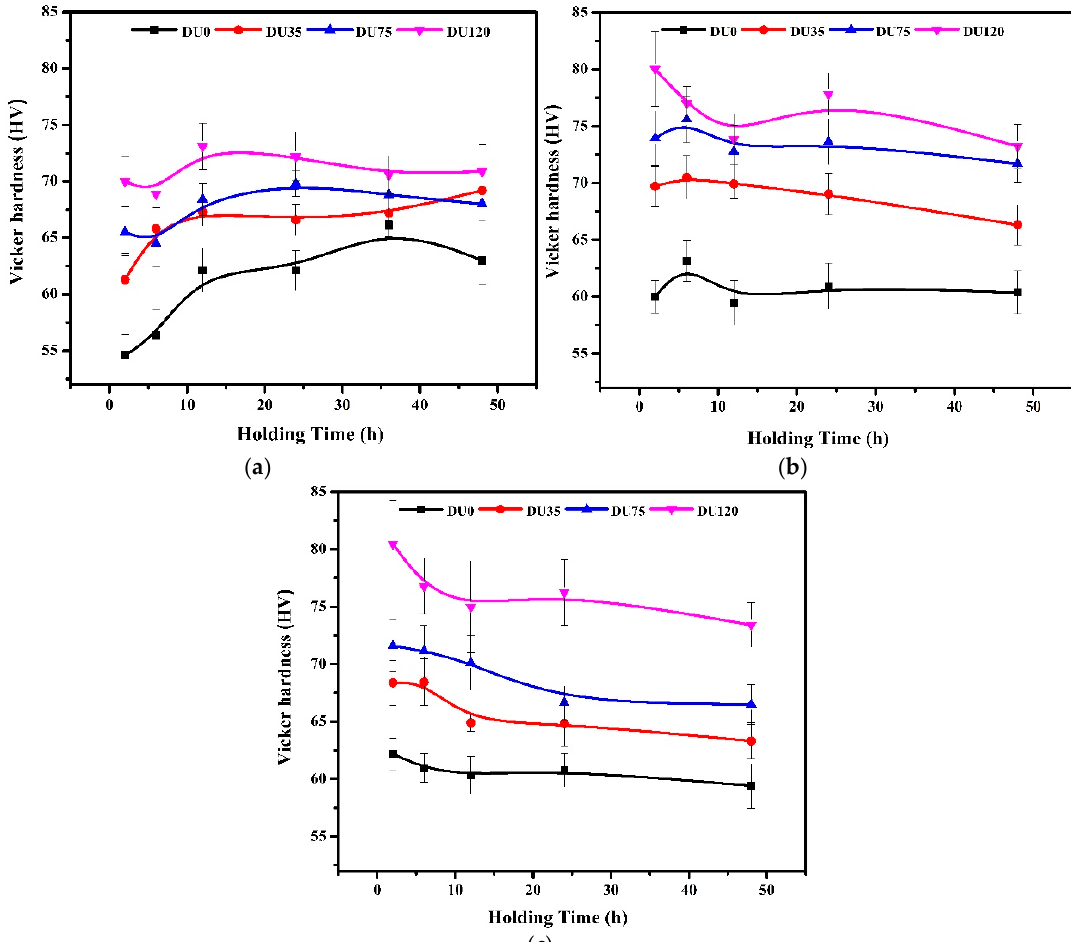
Figure 13. Microhardness of experimental alloys as a function of holding time at ( a ) 375 °C; ( b ) 425 °C and ( c ) 475 °C. Table 2. Peak hardness values and their corresponding times and electrical conductivity.